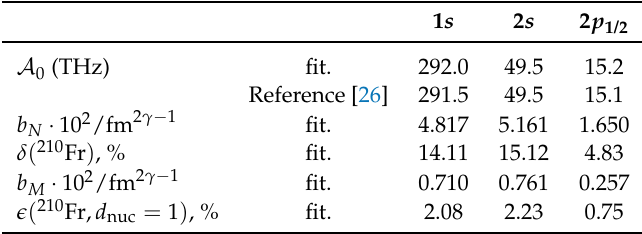
Table 1. Compilation of the fitting parameters for the HFS of the H-like Fr ion. BR and BW corrections δ and (cid:101) for 210 Fr 86 + are calculated for R = 7.1766 fm [30] and d nuc = 1. Parameters δ and (cid:101) are given in percent. 1 s 2 s 2 p 1/2 A 0 (THz) fit. 292.0 49.5 15.2 Reference [26] 291.5 49.5 15.1 b N · 10 2 /fm 2 γ − 1 fit. 4.817 5.161 1.650 δ ( 210 Fr ) , % fit. 14.11 15.12 4.83 b M · 10 2 /fm 2 γ − 1 fit. 0.710 0.761 0.257 (cid:101) ( 210 Fr, d nuc = 1 ) , % fit. 2.08 2.23